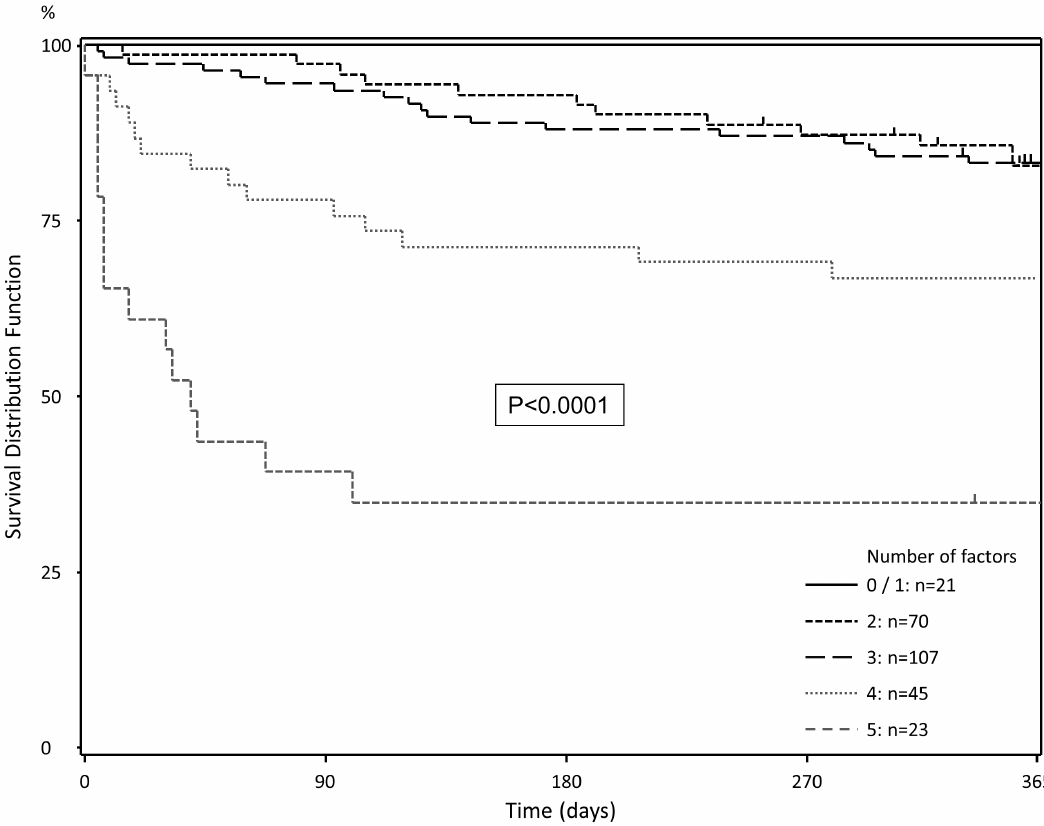
Figure 2. Survival stratified for number of positive risk factors. With an increasing number of risk-factors, postoperative 90-day and 1-year mortality increased (0–1: 0 and 0%; 2: 2.9 and 17.4%; 3: 5.6 and 16.8%; 4: 22.2 and 33.3%; 5: 60.9 and 66.2%).